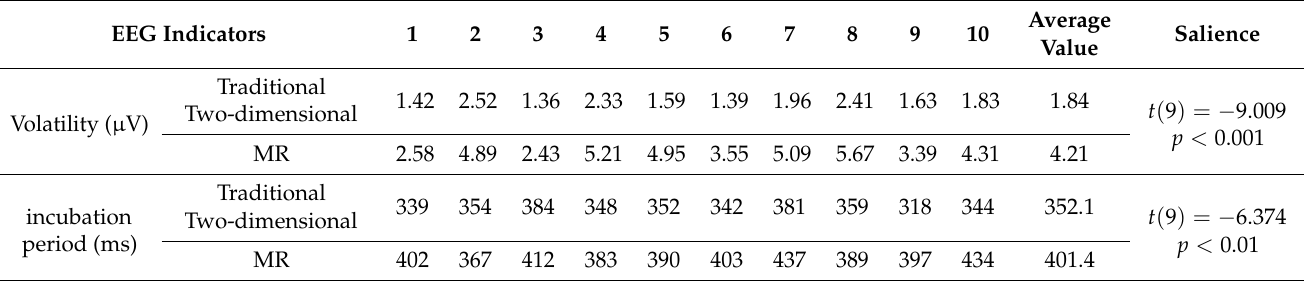
Figure 17. Electrode position layout. Table 5 and Figure 18 were obtained from the statistical P300 EEG data of the experimenter. Table 5. P300 Volatility and